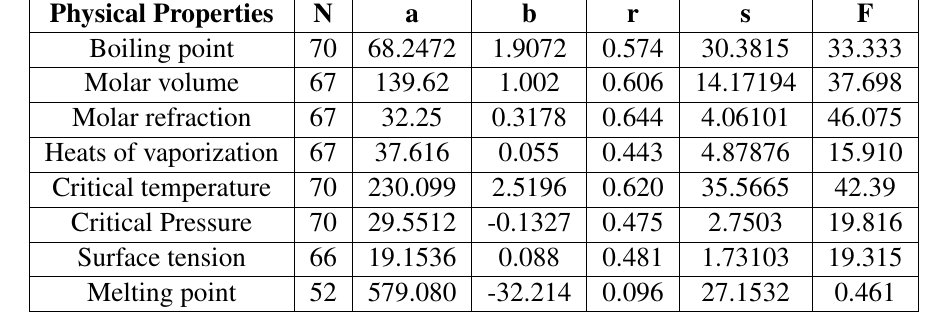
Table 4. Statical parameters for the linear QSPR model for terminal Wiener index.